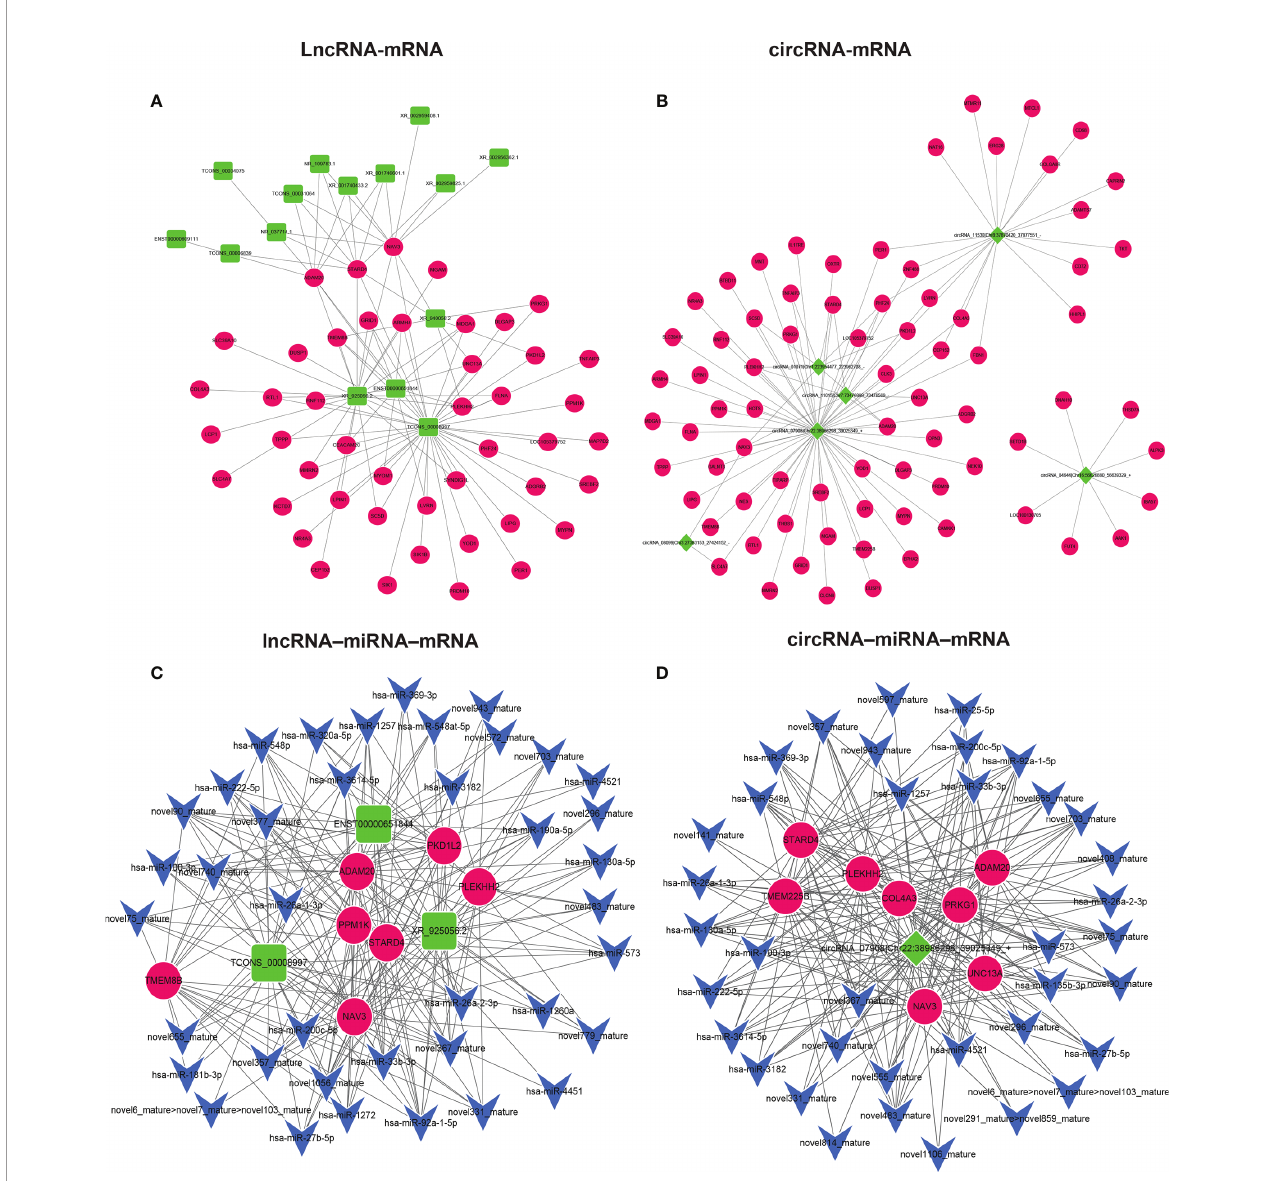
FIGURE 5 | ceRNA – mRNA and ceRNA-miRNA – mRNA regulatory networks in GA-Me-treated HCT116 cells. (A) Interaction network of lncRNAs and mRNAs in HCT116 cells after GA-Me treatment. (B) Interaction network of circRNAs and mRNAs in HCT116 cells after GA-Me treatment. (C) Interaction network of lncRNAs, miRNAs, and mRNAs in HCT116 cells after GA-Me treatment. (D) Interaction network of circRNAs, miRNAs, and mRNAs in HCT116 cells after GA-Me treatment. Red and green represent up- and downregulation,